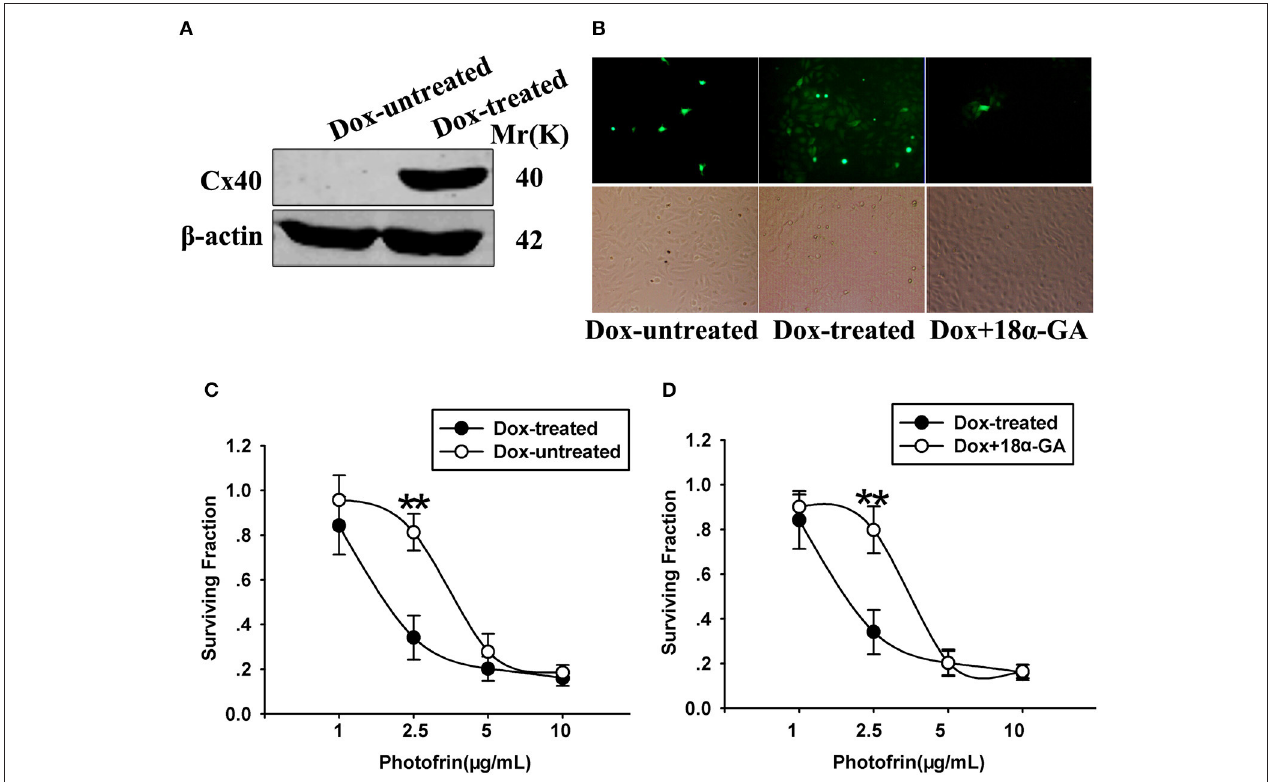
FIGURE 2 | (A) Cx40 expression in Dox-treated and -untreated cells was detected by Western blot assay; (B) 18 α -GA prohibited dye transfer via Cx channels as measured by “parachute” assay. (C,D) Cell survival after PDT in cells treated with and without Dox and 18 α -GA. Data points are mean ± SD from 4 to 7 experiments. t- test was used to assess statistically significant differences between groups. ** P < 0.01, significantly different from Dox-treated